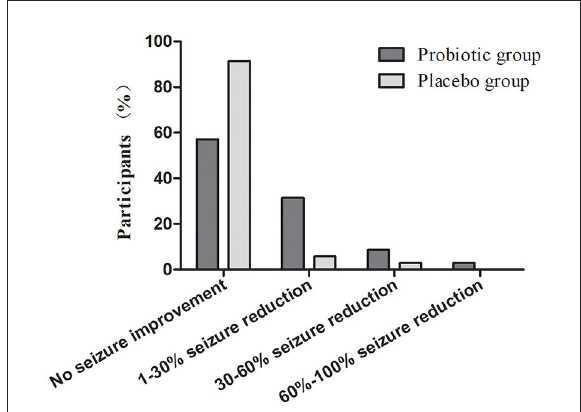
FIGURE2 Level of seizure improvement in participants with epilepsy after receiving treatment of probiotic and placebo.